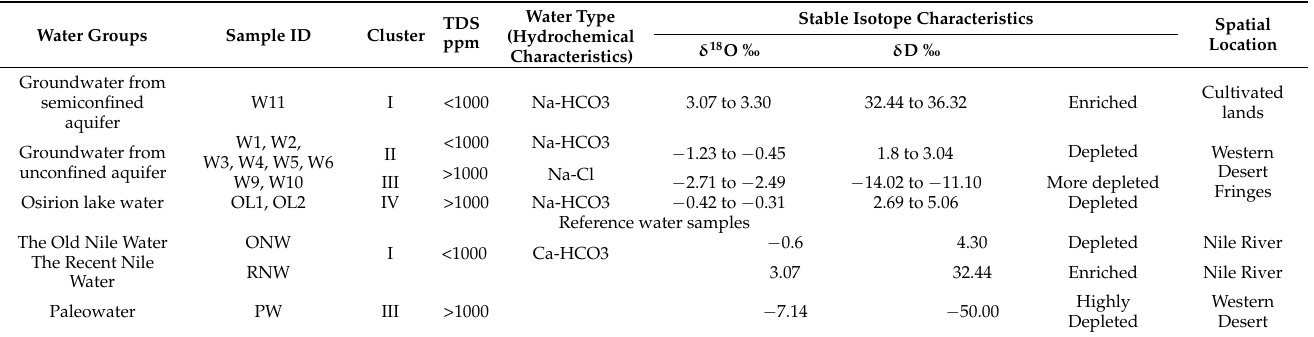
Table 2. An overview table showing the TDS, hydrochemical, isotopic, and geographic locations of the several clusters identified in the confined or semiconfined Quaternary aquifer groundwater in the study region.